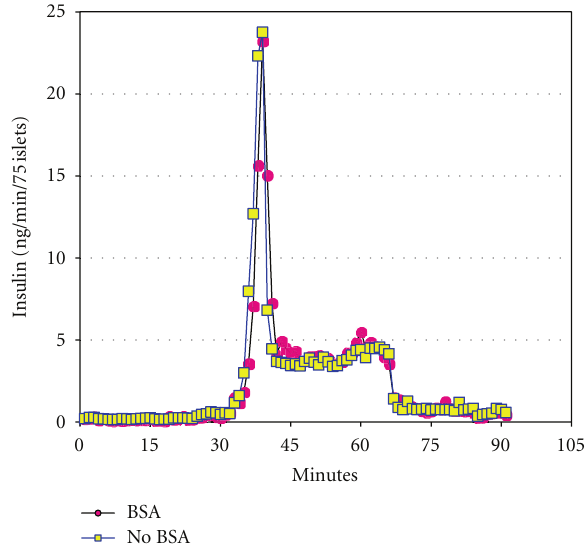
Figure 3: Perifusion assay after 24 hours in culture. A dynamic perifusion assay for insulin response was performed with 75 islets in each group. After a 30 minute preincubation step, islets were exposed for 30 minutes to low glucose (2.8mM) then for 30 minutes to high glucose (20mM) and back to 30 minutes of low glucose. Circle shapes represent the BSA group and square shapes represent the group with No BSA. Graph shown was one of 9 assays performed. There was no significant di ff erence between the 2 groups for insulin response to glucose at 24